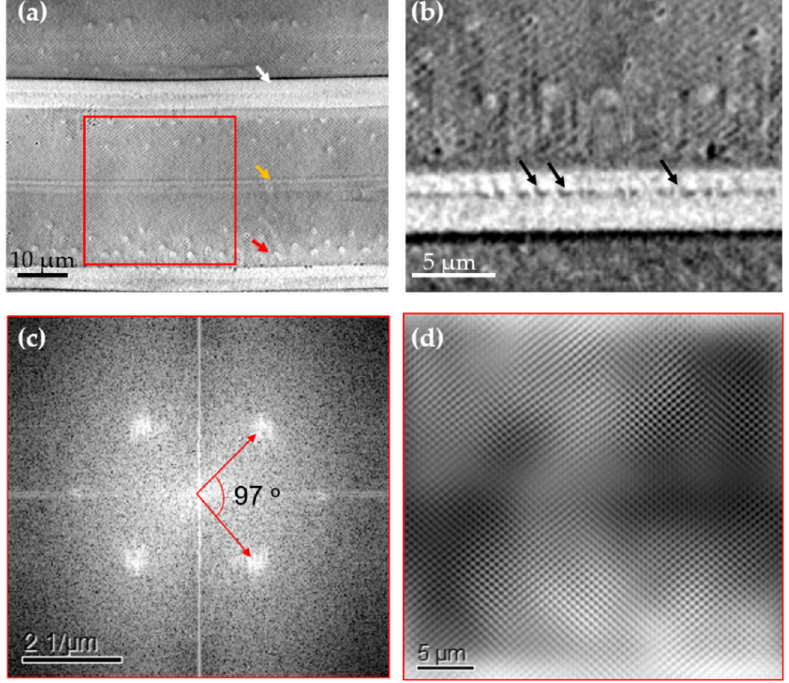
Figure 2. Data analysis of the Ellerbeckia mantle wall. ( a ) Part of the unfolded frustule wall, ( b ) magnified imaging of the morphology of the interlocking series of ridges and grooves (black arrows) on the valve faces, ( c ) FFT analysis of pores on the frustule wall from the red square area in (a) and ( d ) reconstructed outer wall.